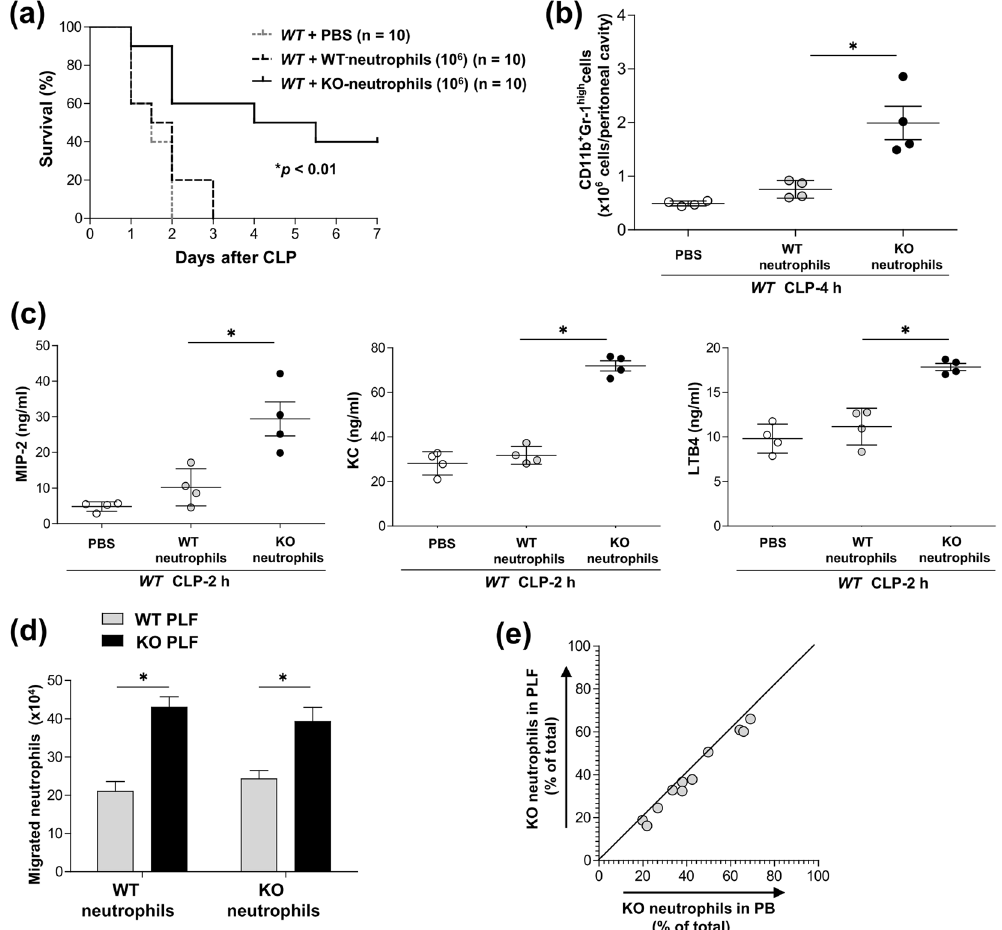
Figure 4. CD300f − / − neutrophils recruited to the peritoneal cavity contributed to enhanced neutrophil migration in a CLP model. ( a–c ) CLP-operated WT (Ly5.1 + ) mice were intraperitoneally injected with 10 6 cells of WT (Ly5.2 + ) or CD300f − / − (Ly5.2 + ) neutrophils or PBS as a control (n = 6 per genotype). ( a ) The mice were monitored regarding survival; * p < 0.01 compared to the mice inoculated with WT neutrophils (log-rank test). ( b , c ) Numbers of Ly5.1 + neutrophils ( b ) or levels of MIP2, KC, or LTB4 ( c ) in PLF (each, n = 4). ( d ) Numbers of WT or CD300f − / − neutrophils that migrated into the lower wells containing PLF derived from either WT or CD300f − / − mice 4 h after CLP. ( e ) The proportions (%) of CD300f − / − neutrophils among CSFE-positive neutrophils present in PB or PLF from the chimeric mice (each, n = 4) 4 h after CLP. Values on the X and Y axes represent the percentage in PB and PLF, respectively. ( a–e ) The data are representative of two independent experiments. The data are expressed as mean ± SD; * p < 0.01 (Student’s t